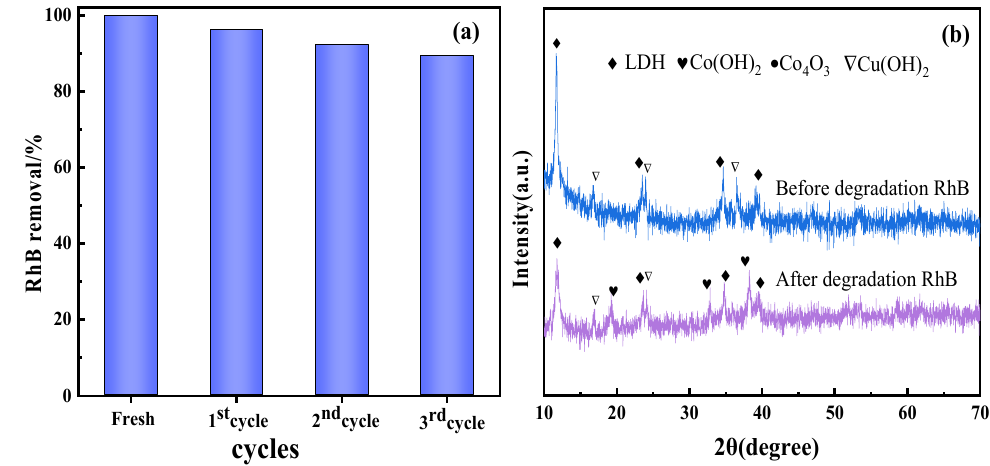
Figure 10. The reusability and stability of Cu–Co t = 65 °C catalyst ( a ); and XRD diffractograms before and after degradation ( b ).